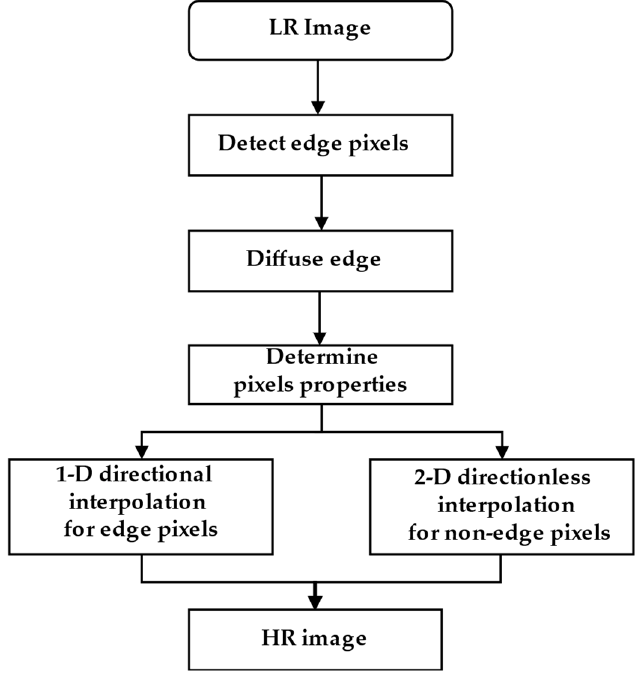
Figure 9. Structure of the proposed method.